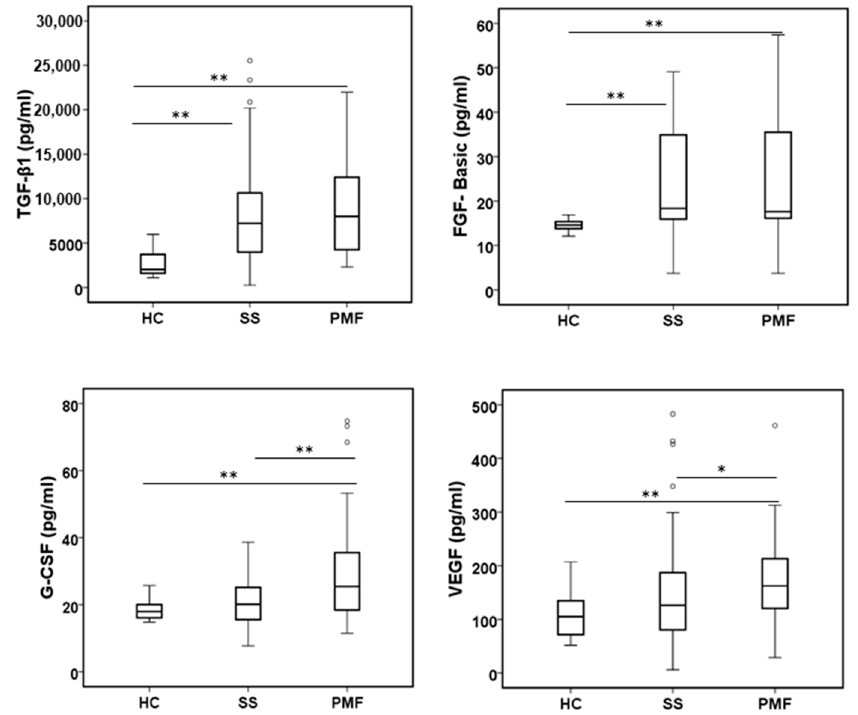
Figure 5. Levels of growth factors in plasma from peripheral blood were assayed in all participants. All growth factors were assayed by the Bio-Plex assay except TGF- β 1, which was assayed by a Human TGF- β 1 Elisa Kit from Sigma-Aldrich. * and ** indicate significance p < 0.05 and p < 0.01, re- spectively.